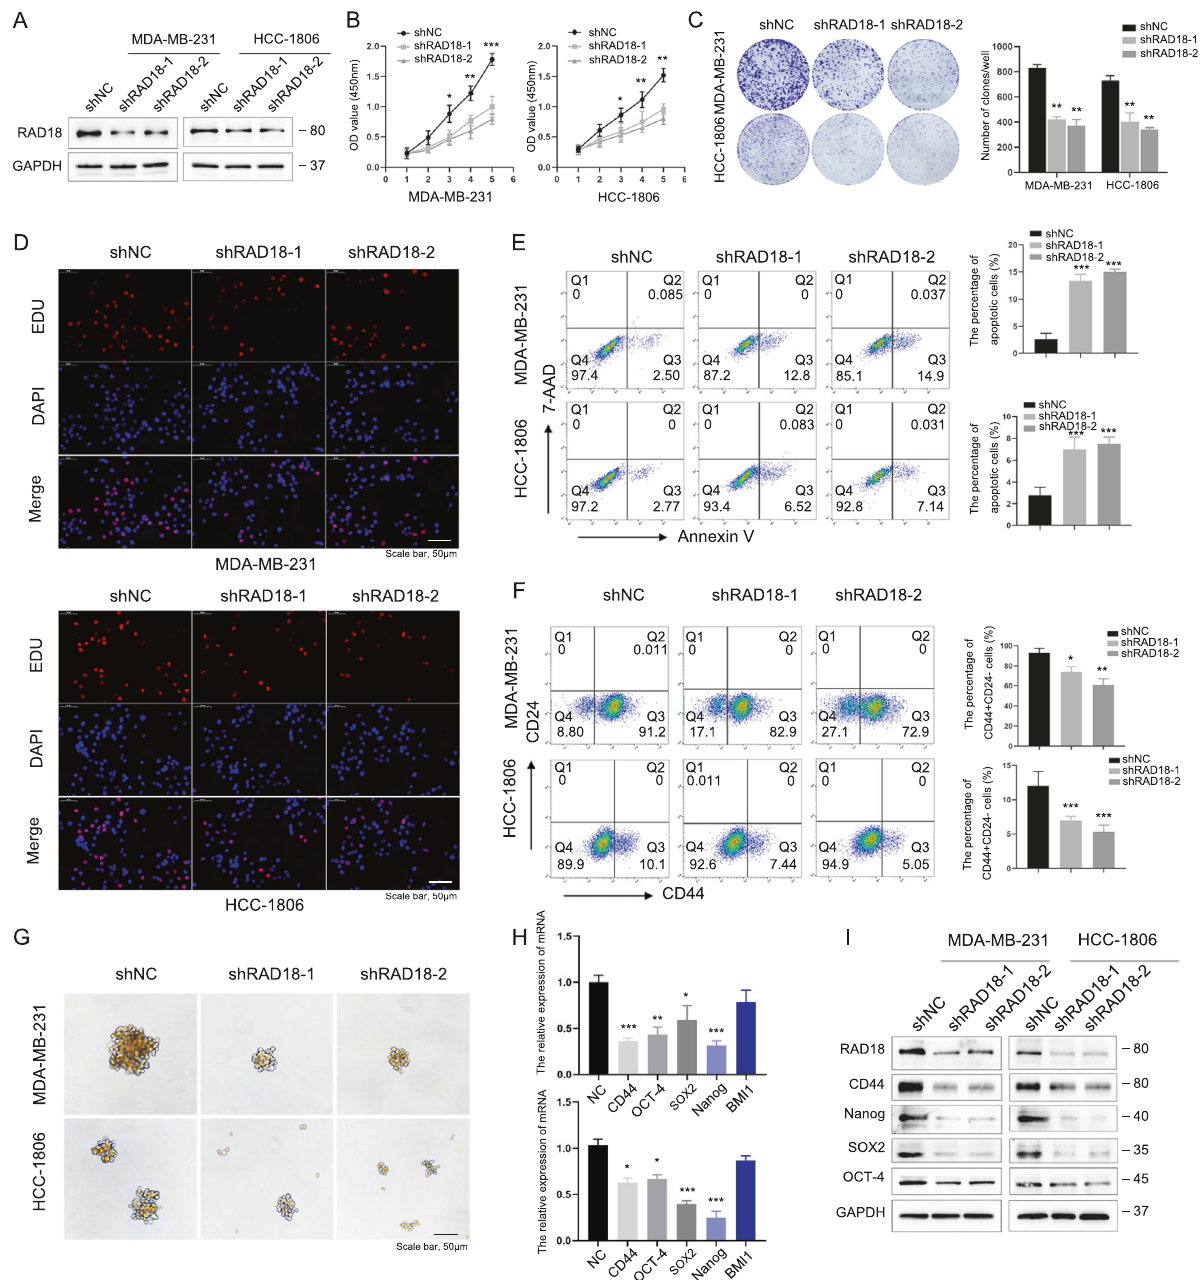
Fig. 2 RAD18 promotes TNBC cell proliferation and maintains the stemness of TNBC in vitro. RAD18 increases TNBC cell proliferation and maintains the CSC stemness in vitro. A RAD18 protein levels in TNBC cells transfected with RAD18 shRNA lentivirus were determined by western blotting. B Cells were seeded in a 96-well plate and CCK-8 assay was used to detect cell proliferation at indicated hours (24, 48, 72, 96, and 120 h). C colony formation assay was performed to examine cell proliferation. Cells were seeded in six-well plates at a density of 2000 cells per well and cultivated for 2w. D An EdU assay was performed to determine the proliferation of different groups of TNBC cells. E Cell apoptosis in shNC and shRAD18 TNBC cells were assessed by Annexin V/7 ‐ AAD fl ow cytometric analysis. F Representative fl ow cytometric analysis of CD44 + /CD24 − BCSC population percentages in shNC and shRAD18 TNBC cells. G The tumor sphere formation in TNBC cells treated as indicated (200×). The quanti fi cation of mammospheres were counted using a microscope with size ≥ 50 µm. H , I mRNA and protein levels